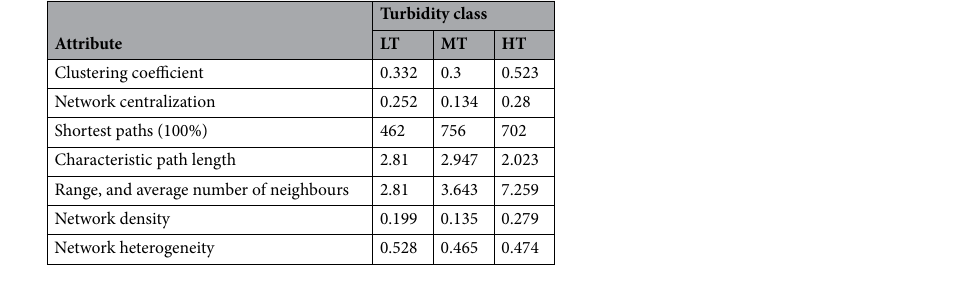
Table 2. General attributes of the zooplankton network in compared turbidity